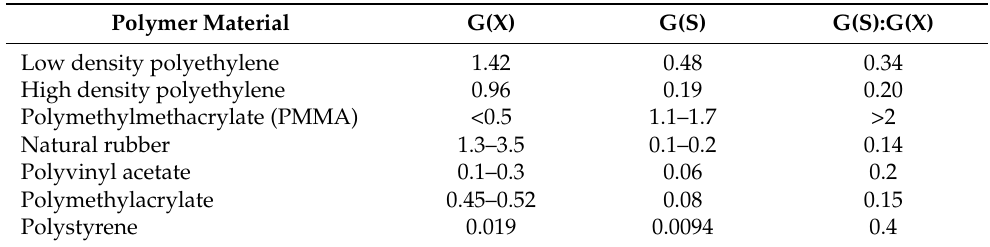
Table 3. Values from the literature data for radiochemical yields G(X) and G(S) for various polymeric